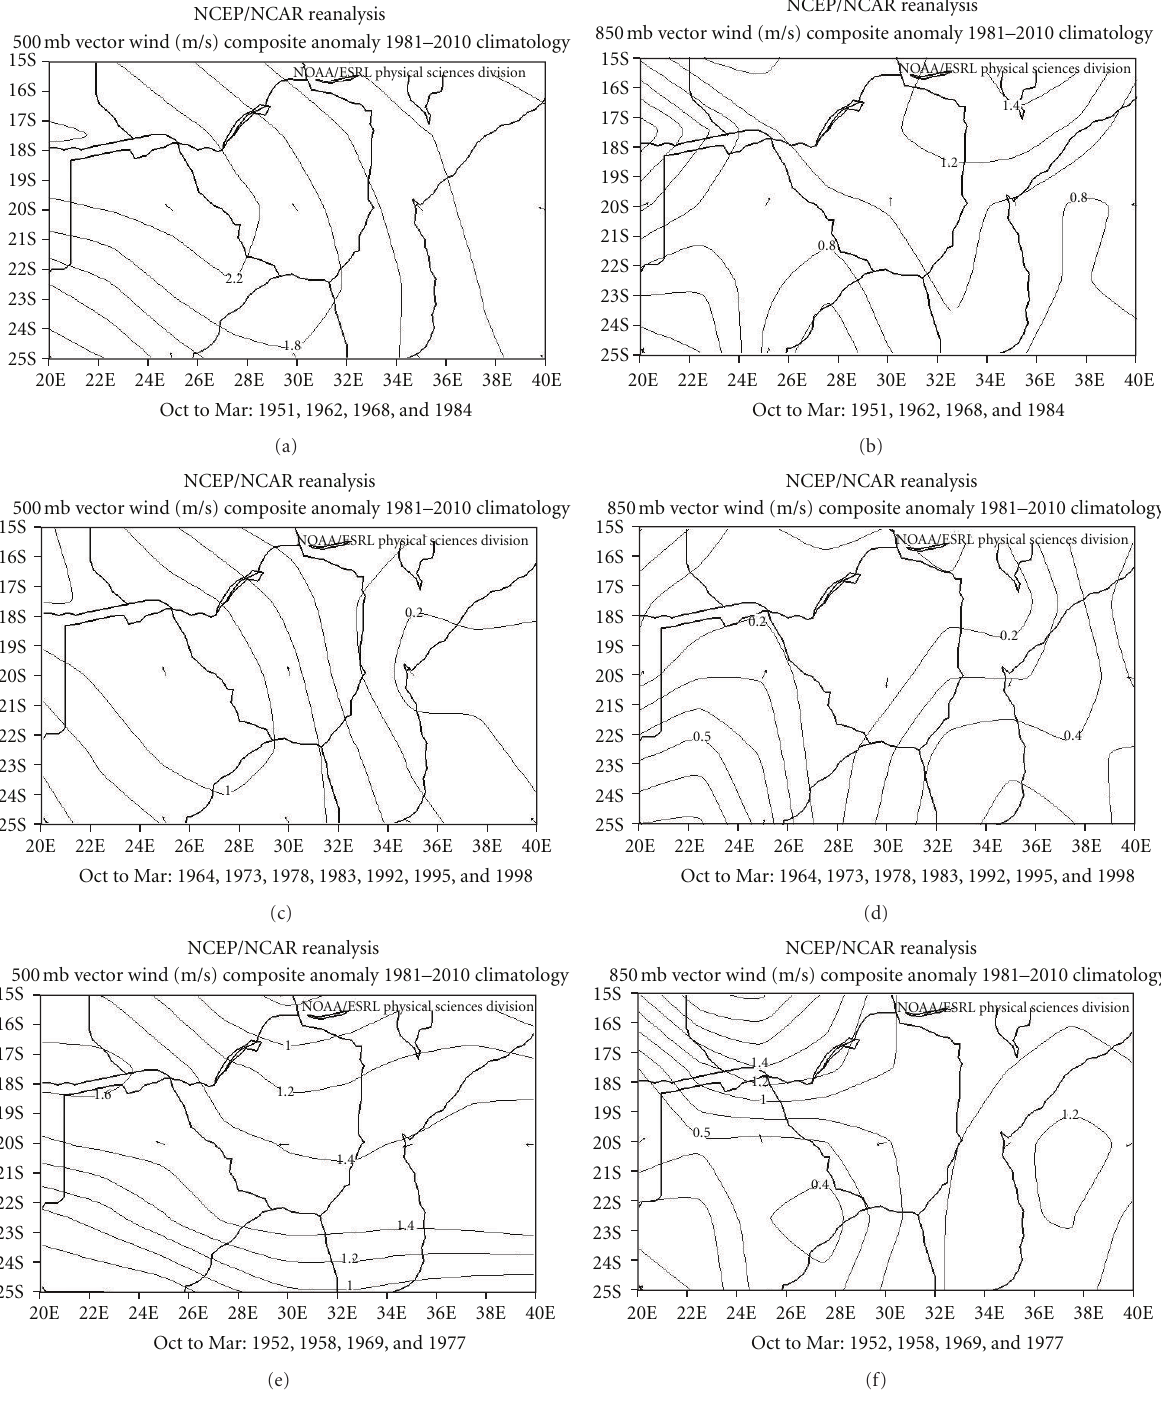
Figure 9: Vector wind pattern (m/s) for the 500 mb and 850 mb pressure level for (a) and (b) pure IODZM composite, (c) and (d) cooccurrence composite, and (e) and (f) pure El Ni˜no composite over the east-central southern African